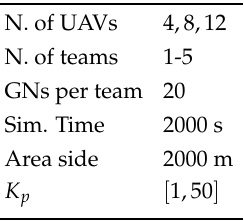
Table 2. Default simulation